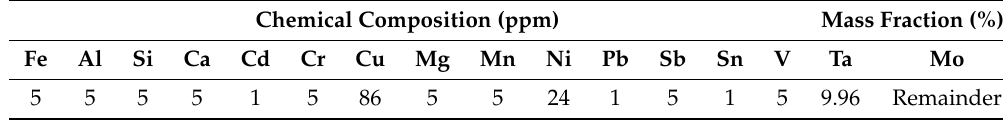
Table 1. The chemical composition of Mo-10Ta.